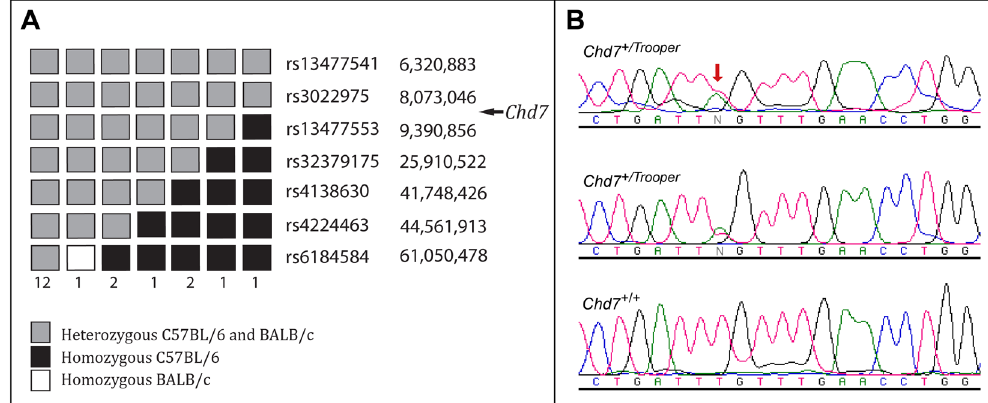
Figure 1. Trooper mice harbour an intronic point mutation in Chd7 . ( A ) 20 F 1 N 1 mice were classified as hearing impaired following click-ABR testing (threshold ≥ 45 dB SPL). SNP Haplotypes for the proximal region of chromosome 4 are illustrated, with the numbers below each haplotype representing the number of mice observed with that haplotype. The region between the centromere and rs13477553 was heterozygous in all hearing impaired mice. ( B ) DNA sequence electropherograms of a region of Chd7 intron 9 in two hearing impaired Trooper mice and an unaffected littermate. Both affected mice were heterozygous for a c.3219-18T > A mutation in Chd7 , which was predicted to affect splicing.